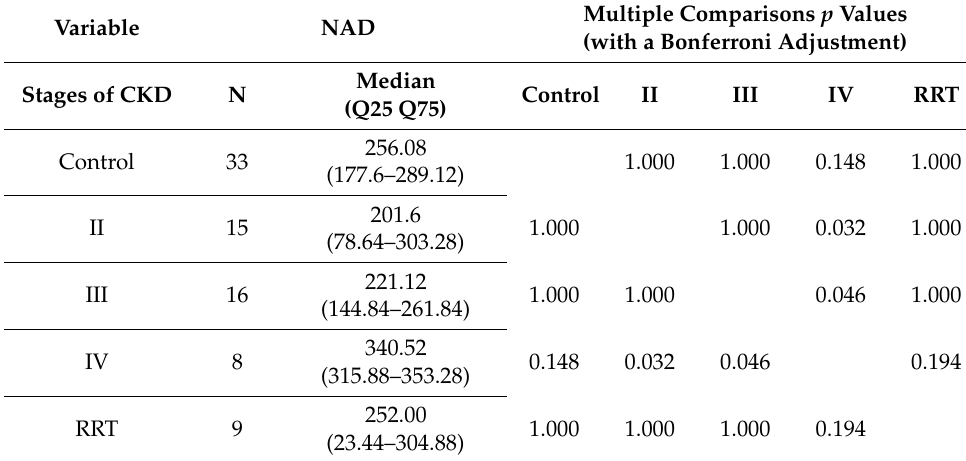
Table 4. Differences between stages of CKD severity for NAD.